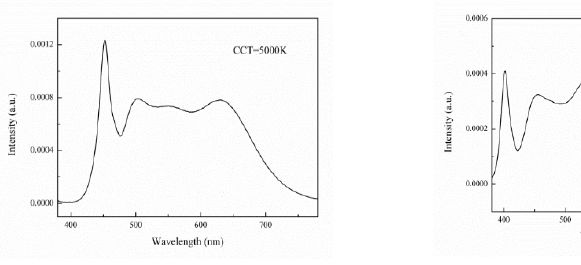
are shown below (Figure 4) [72].